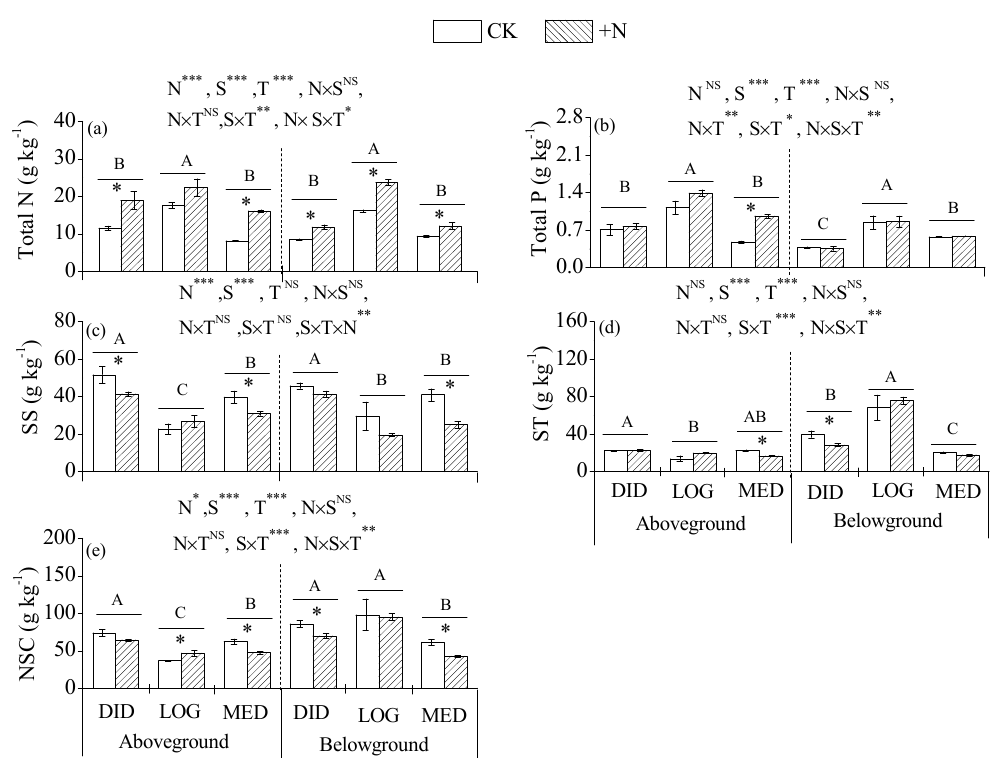
Figure 2. Total nitrogen ( a ), total phosphorus ( b ), soluble sugar ( c ), starch ( d ) and nonstructural ccarbohydrates ( e ) concentrations in aboveground and belowground tissues of the three understory plant species in the Chinese fir plantation treated by nitrogen addition (+N) or in the control (CK). Note: Values shown are the means ± SE ( n = 4). The asterisks (*) indicate significant differences at the p < 0.05 level between the control and N-treatment plots within a single species. Different capital letters indicate significant differences ( p < 0.05) among the three species within the same tissue based on Duncan’s multiple range test. Total N = total nitrogen, Total P = total phosphorus, SS = soluble sugar, ST = starch, NSC = nonstructural carbohydrates; N = nitrogen addition, S = species, T = tissues. NS , not significant; * p < 0.05; ** p < 0.01; *** p < 0.001. DID: D. dichotoma , LOG: L. gracile , MED: M. dodecandrum.